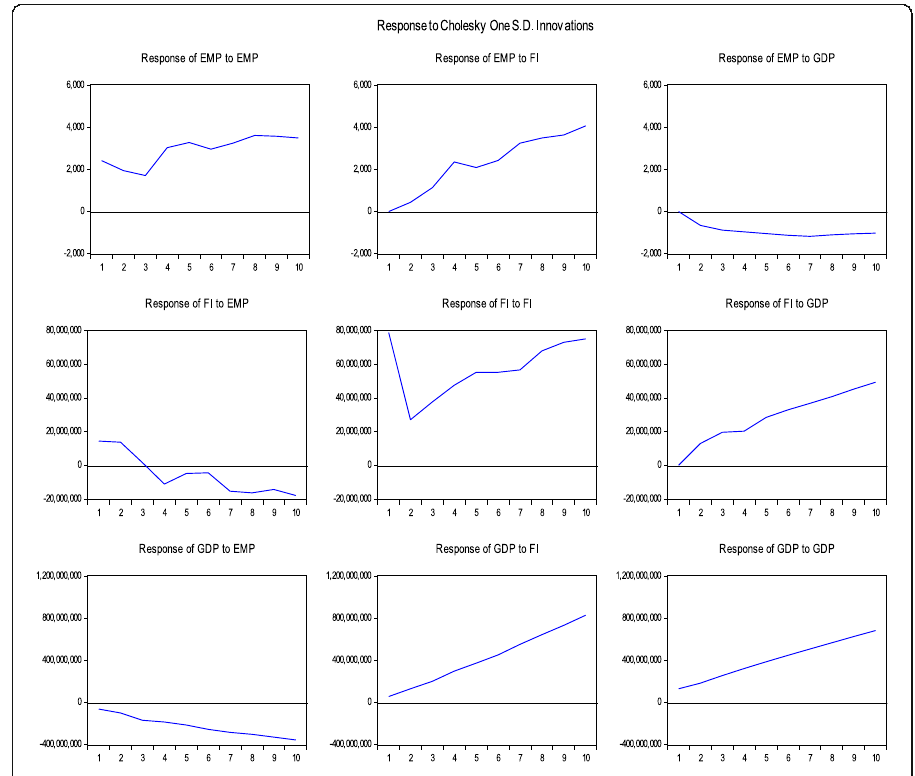
Fig. 1 Impulse Response Test Results. *response to Cholesky One S.D. Innovations from e-views, based on the impulse response of EMP to EMP; EMP to FI; EMP to GDP; FI to EMP; FI to FI; FI to GDP; GDP to EMP; GDP to FI; and GDP to